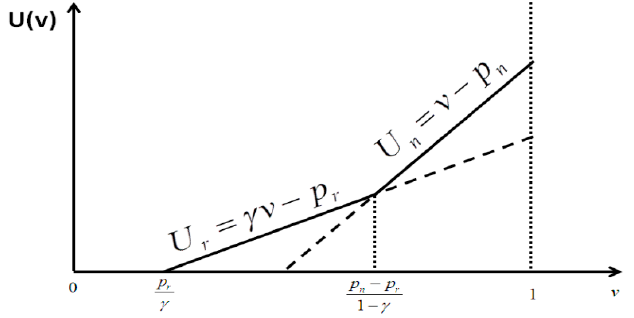
Figure 1. Willingness-to-pay functions for consumers.